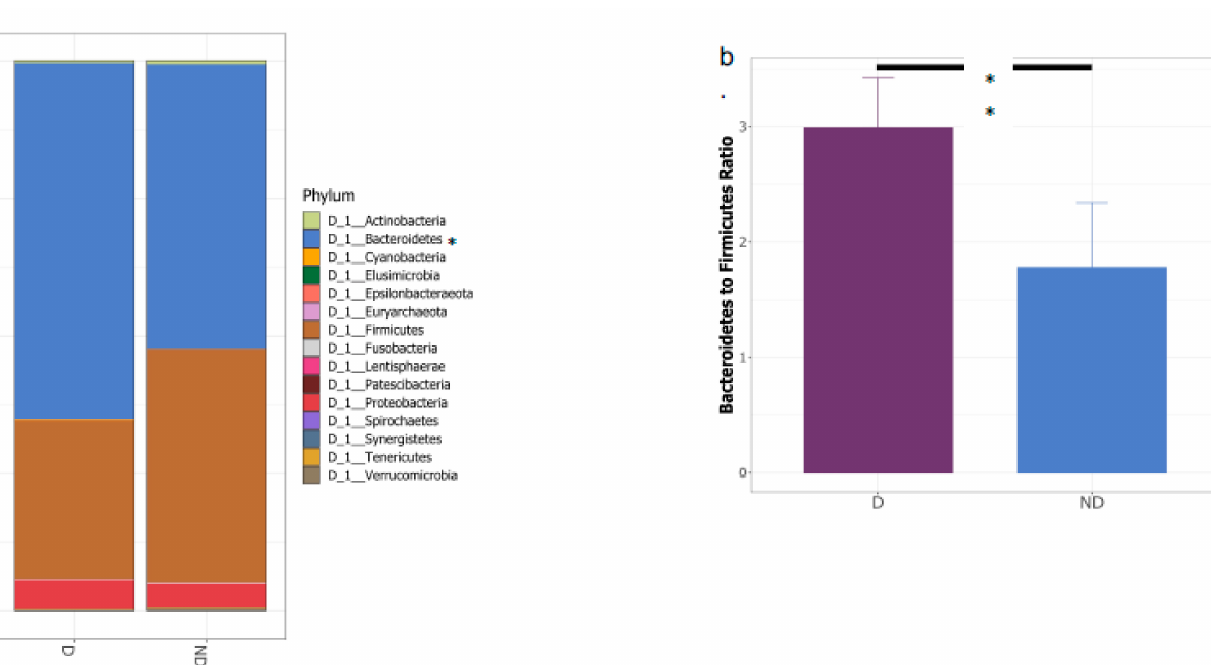
Figure 2. Alpha and beta diversity plot comparisons for the vitamin D deficient (D) and non-deficient (ND) groups. ( a ) Observed species, Chao1, Shannon, and Inverse Simpson boxplots representing the alpha-diversity indices. The horizontal line inside the box indicates the median, while the boxes reflect the interquartile range (IQR) between the first and third quartiles (25th and 75th percentiles, respectively). Whiskers reflect the lowest and greatest values from the first and third quartiles that are within 1.5 times the IQR, respectively. The Wilcoxon test with FDR–Bonferroni corrected p values was used to determine statistical significance. * p < 0.05; ( b ) CCA plot showing the beta diversity measure ** p < 0.01 deep purple: deficient samples, blue: non-deficient. Each dot represents an individual sample. The figure was generated using RStudio v 1.4 with R v 4.1.